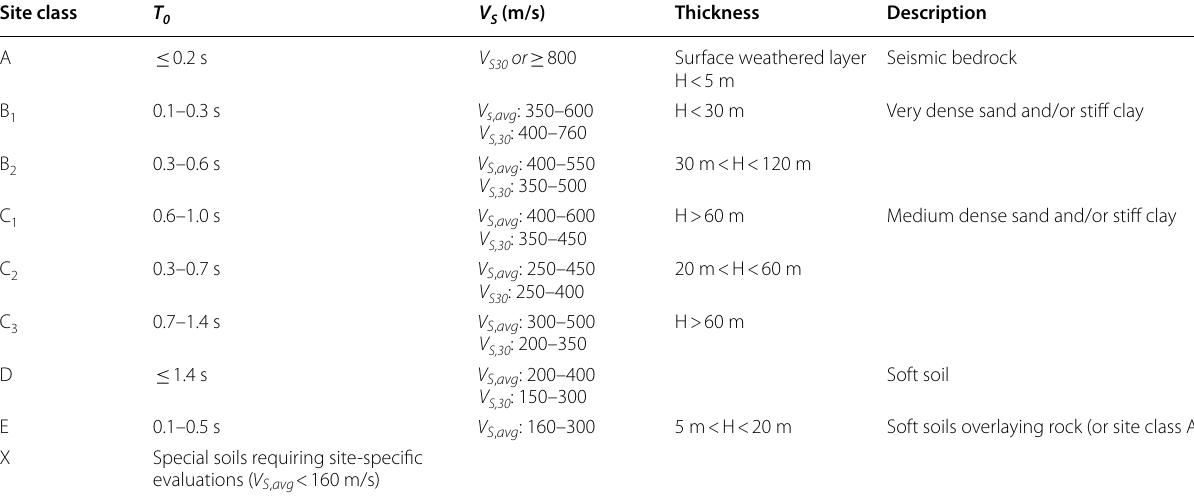
Table 3 Site classifications scheme according to Pitilakis et al.